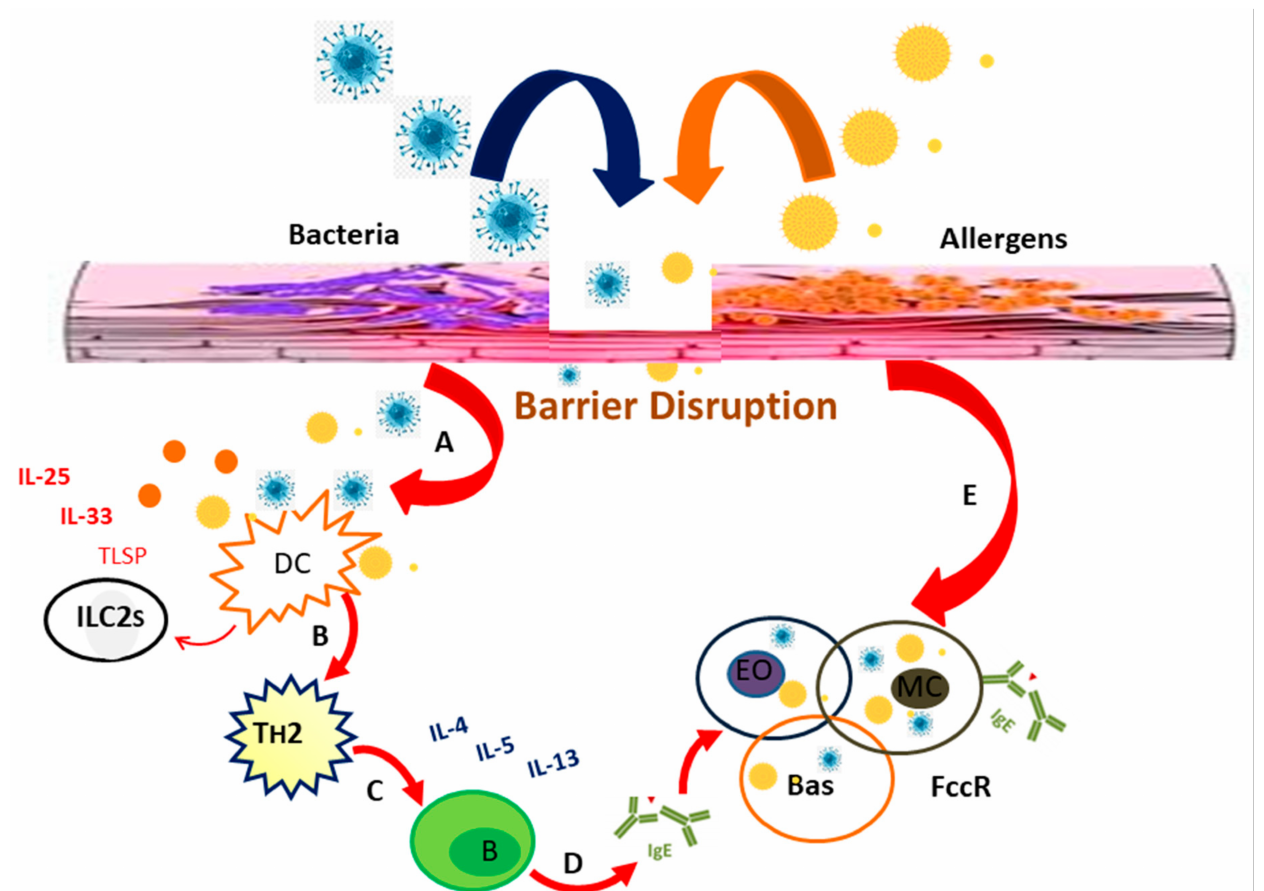
Figure 4. Allergy inducing mechanisms of bacteria. * Eo, eosinophil; FC ε R, high affinity IgE receptor; B, B cell; Bas, basophil; TSLP, thymic stromal lymphopoietin; MC, mast cell; ILC2, innate lymphoid cell type 2; DC, dendritic cell; Th, T helper